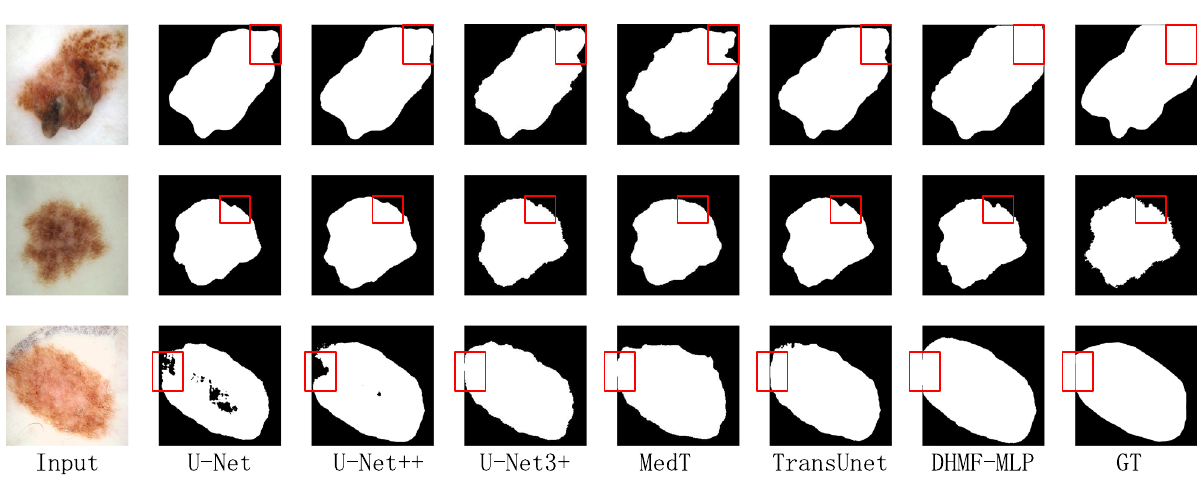
Figure 6. Qualitative comparison results for the ISIC 2018 dataset. From left to right: input, U-Net 14 , U-Net++ 16 , U-Net3+ 28 , MedT 50 , TransUnet 42 , DHMF-MLP and GT. (created by ‘Microsoft Office Visio 2013’ URL: https:// www. micro soft. com/ zh- cn/ micro soft- 365/ previ ous- versi ons/ micro soft- vision- 2013).